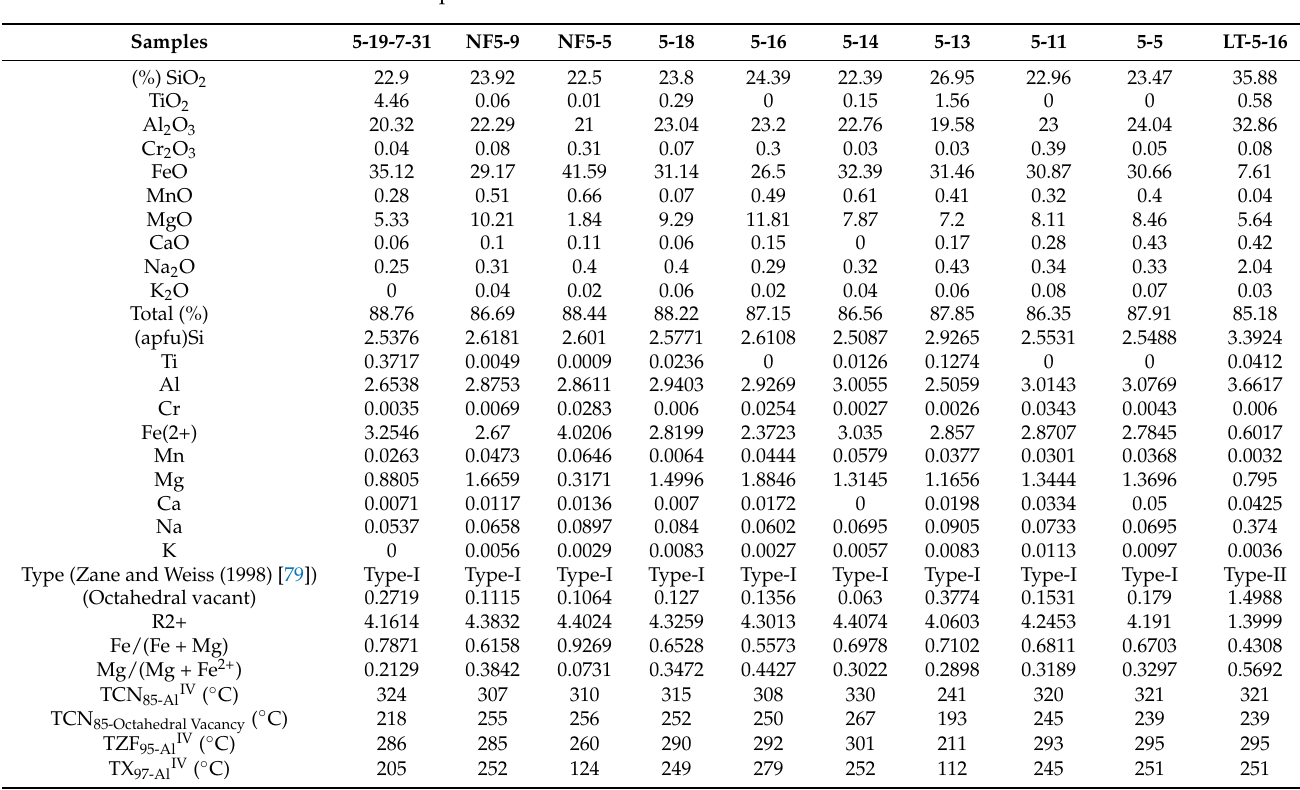
Table 4. Chemical composition (wt %) of chlorite from Lutang deposit analyzed by EPMA, along with their structural formulae and estimated formation temperatures.